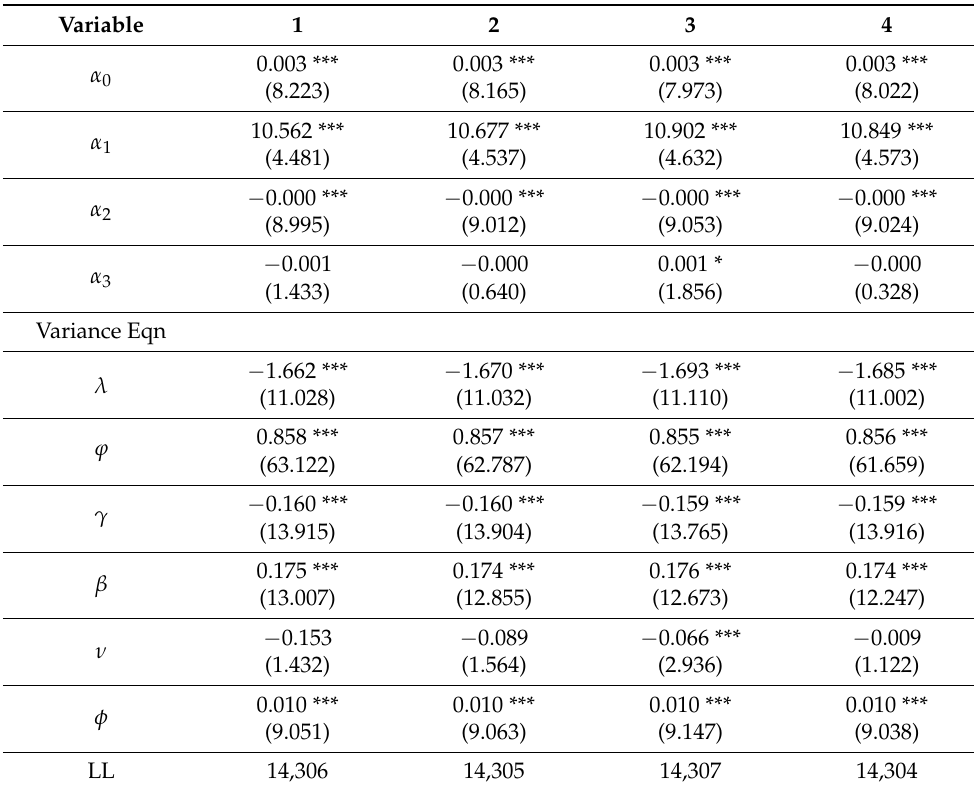
Table 2. Estimates of the event study using the EGARCH(1,1)